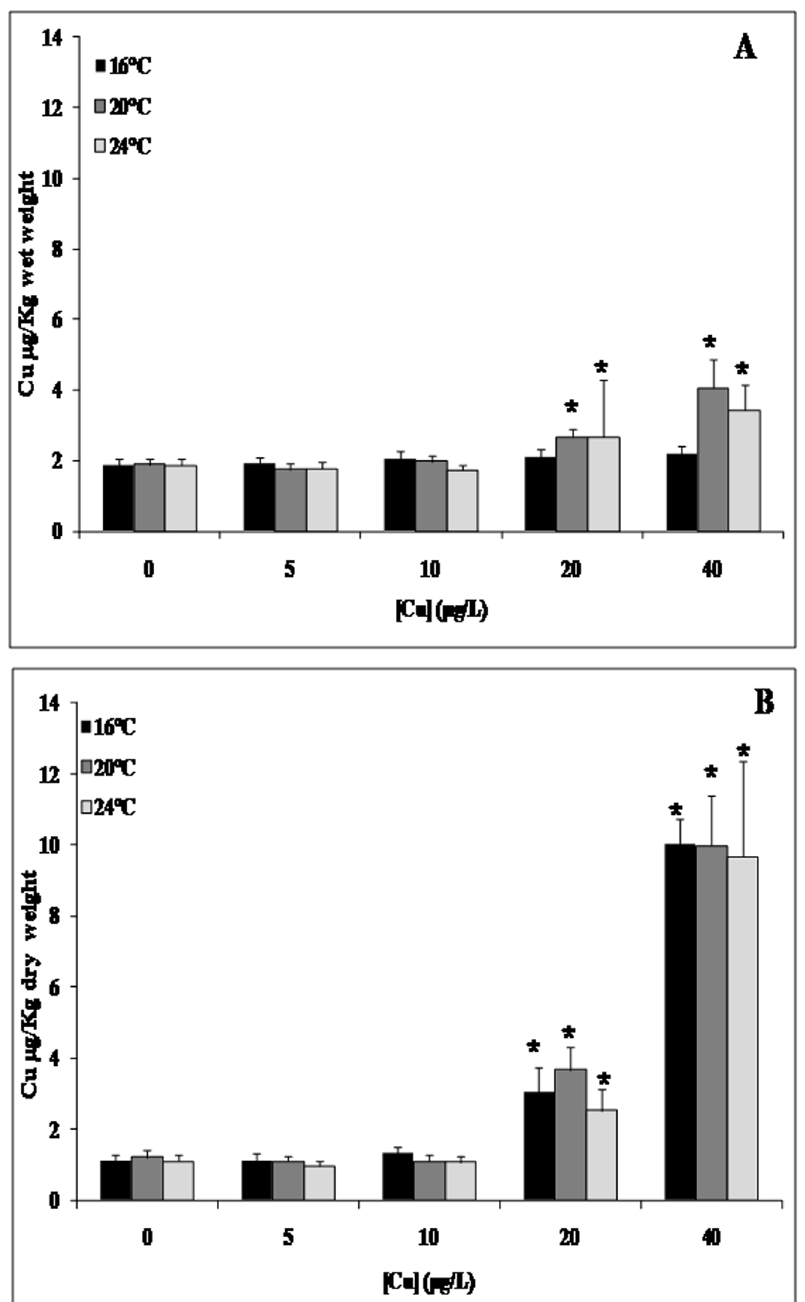
Figure 2. Copper accumulation in Mytilusgalloprovincialis digestive gland (Panel A) and gills (Panel B) in animals exposed for 4 days to increasing Cu concentrations (0; 5; 10; 20 and 40 m g/L) along with a temperature gradient (16 6 C; 20 6 C and 24 6 C) Data, expressed in m g/g dry weight (n=10), were analyzed by ANOVA + Tukey’s post test. *: Statistically significant differences (P , 0.01) in comparison with control condition (16 u C without Cu supply). doi:10.1371/journal.pone.0066802.g002 20 u C and 24 u C (Table 2; Table S5) and common to the responses associated with 10 biological processes, largely composed of to both temperatures (Table 2). Analysis of the 64 DEGs in ‘‘translation’’ processes (23 DEGs). Response to unfolded proteins was represented by five up-regulated DEGs in animals exposed to animals exposed to 20 u C (versus 16 u C) highlighted the following contributing biological processes: protein polymerization, cellular 24 u C (table S4). Four heat shock proteins were included in this protein metabolic processes, microtubule-based movement, and class (heat shock protein 70, AJ624049 and AJ624615; heat shock cellular biosynthetic processes (Table S4). In addition, the 136 protein 90, AJ625915; small heat shock protein 26, AJ624926; and DEGs obtained from animals exposed to 24 u C were significantly